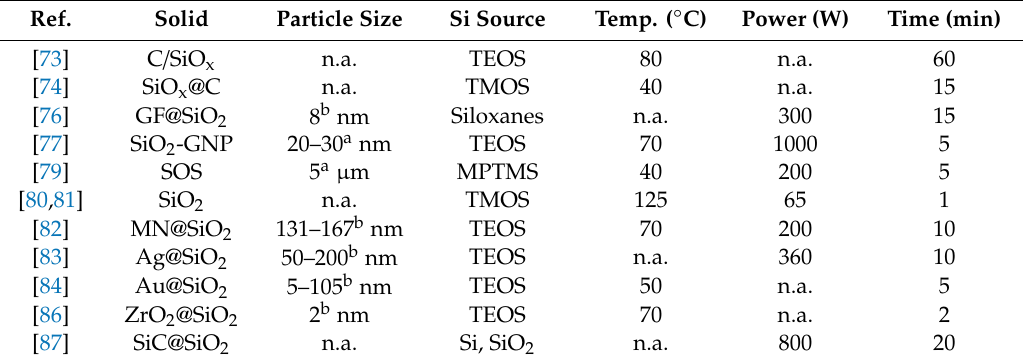
Table 4. Synthesis parameters and characterization of the non-porous silica solids prepared under microwave irradiation.